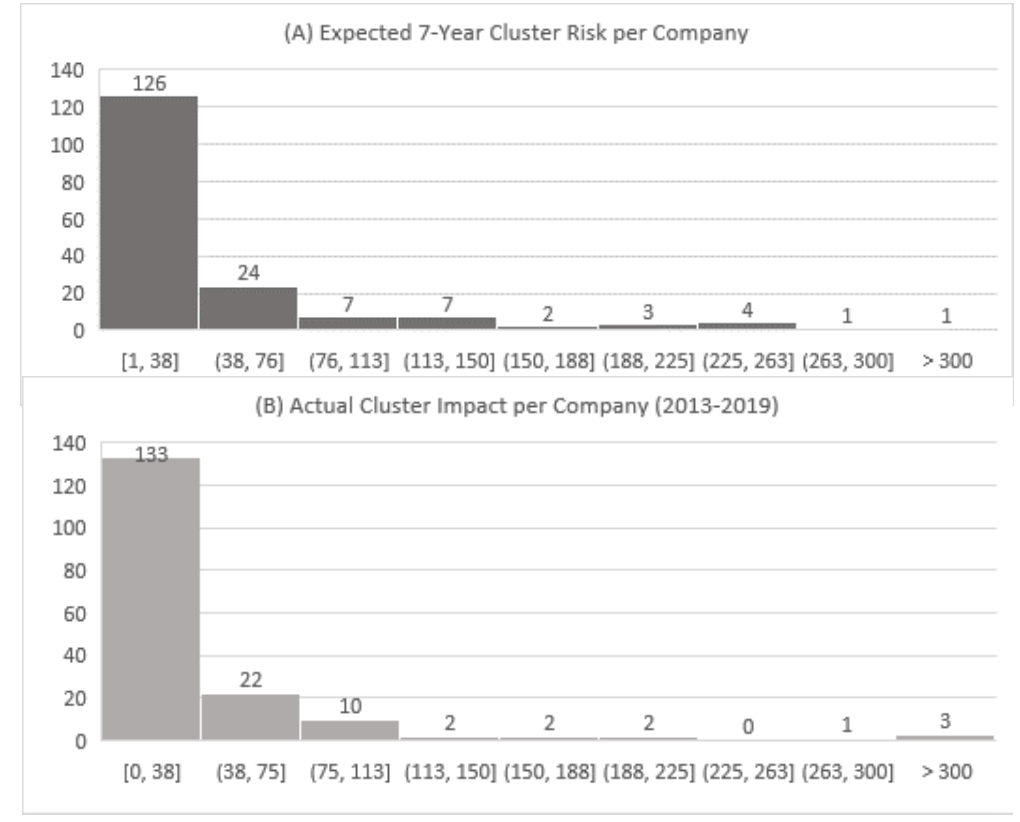
Figure 6. Evaluation of cluster risk estimates.